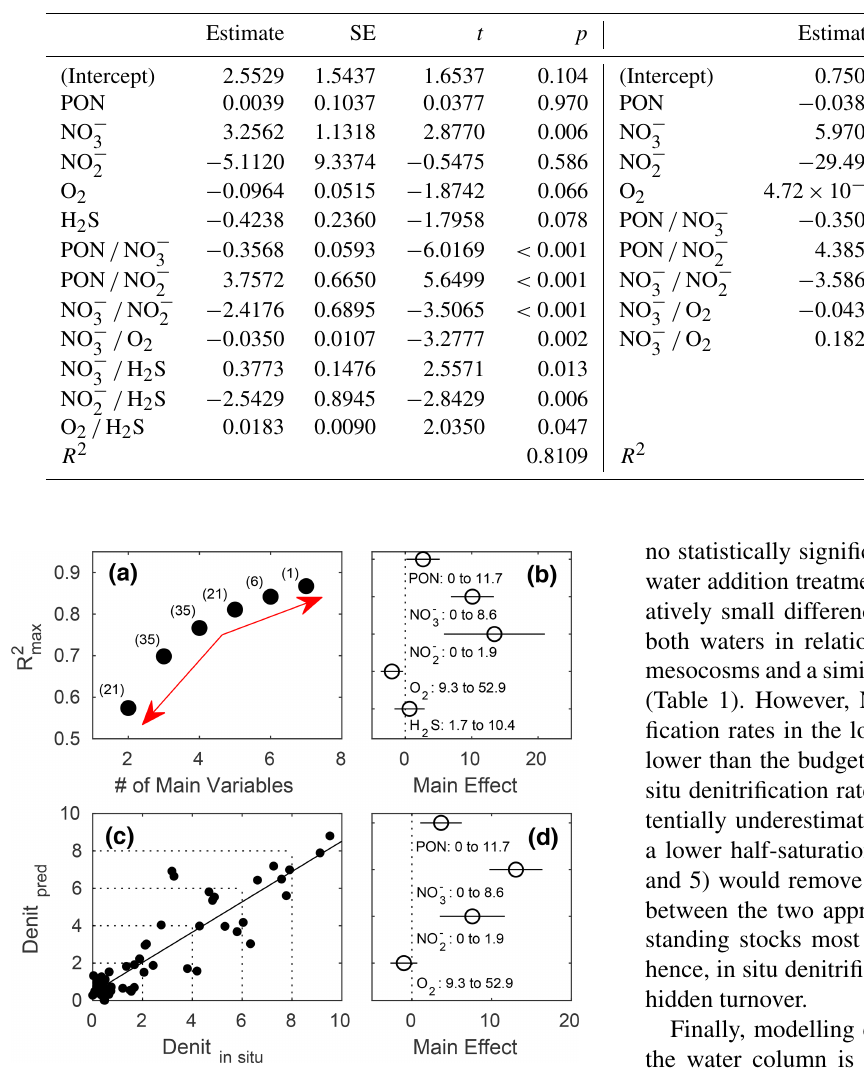
Figure 5. Stepwise multiple linear regressions (MLRs) of in situ denitrification rates in the mesocosms against up to seven poten- tial predictors and their interactions (PON, PON sed , DON, NO − NO − , O 2 , and H 2 S), with the (a) reducing numbers of measured 2 variables and resulting maximum R 2 . The red arrows denote the relatively small increase in maximum R 2 beyond five main vari- ables and the relatively large decrease below, indicating this to be the sweet spot in terms of balancing the model complexity with predictive power and avoiding overfitting (see Sect. 2 for details). Numbers in parentheses denote the number of possible predictor combinations, i.e. MLRs fitted. (b) Main effect sizes of the step- wise MLRs with five main variables and the highest (0.8109) R 2 (compare Table 3). (c) Linear fit through in situ and predicted den- itrification rates (nanomole dinitrogen per litre per hour; hereafter effect sizes of the stepwise MLR with four main variables and the highest (0.7666) R 2 (compare Table